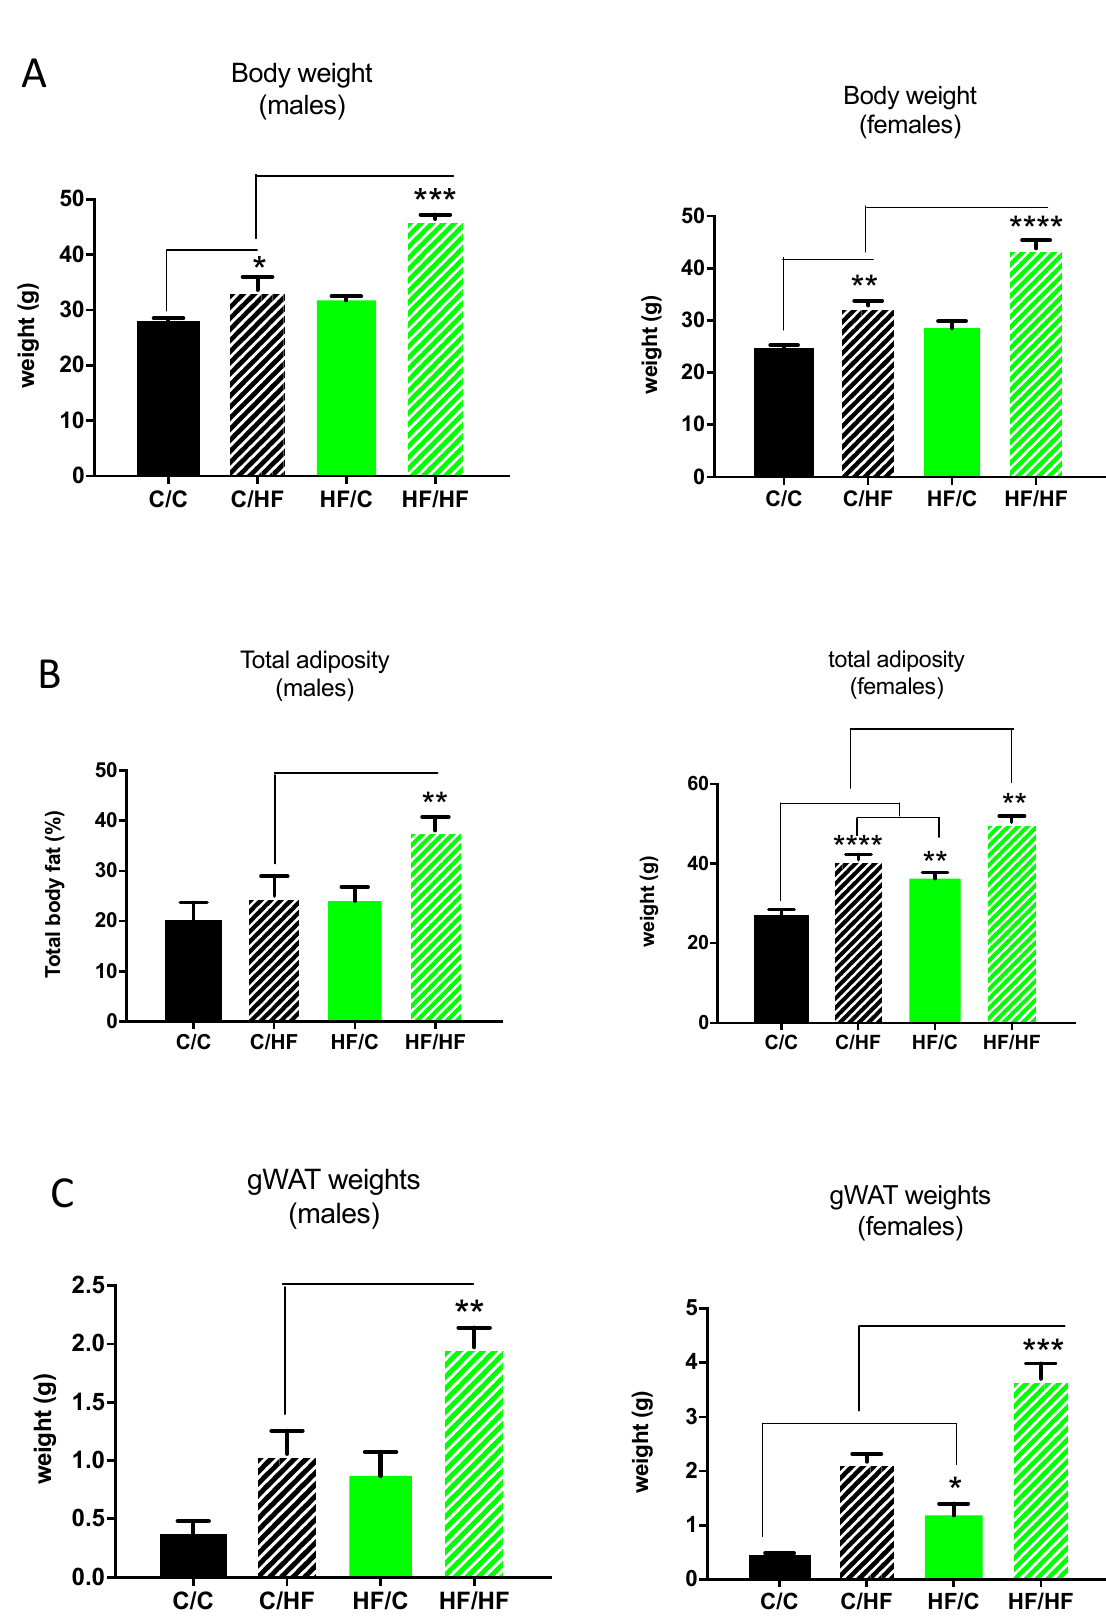
Figure 1. Body weight ( A ), total adiposity ( B ), and gonadal white adipose tissue (gWAT) weights ( C ) in male and female chow (C)- or high-fat (HF)-fed 30-week-old offspring of dams fed a chow C or HF diet for 6 weeks prior to pregnancy and during pregnancy and lactation. All data represent means ± SEM. Data was analysed by ANOVA and Tukey’s multiple comparison test. N = 5–7. * p < 0.05, ** p < 0.01, *** p < 0.001, **** p <